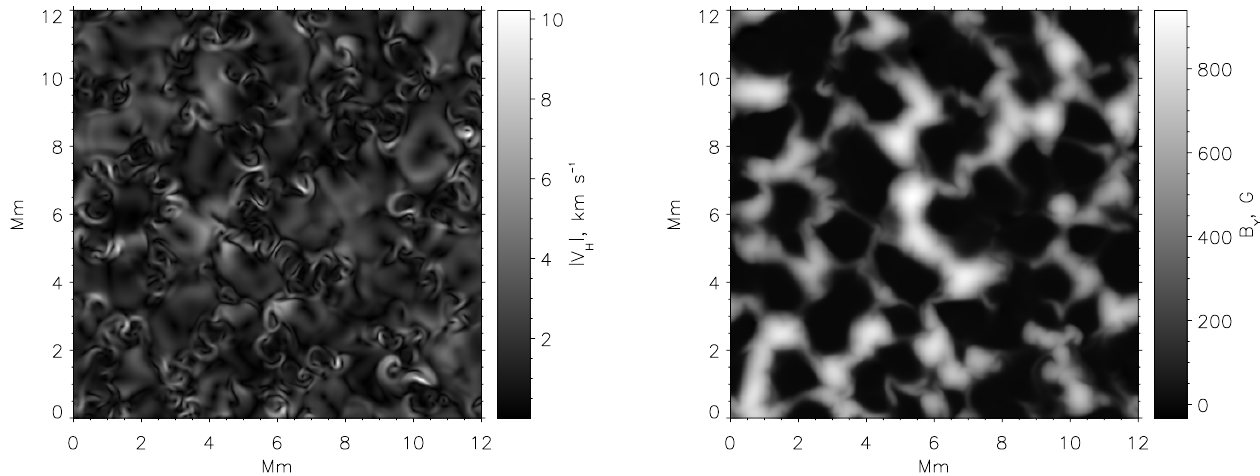
Fig. 1. Modulus of the horizontal components of velocity (left panel) and the vertical component of magnetic field, taken at the height of approximately 500km above the visible solar surface level.